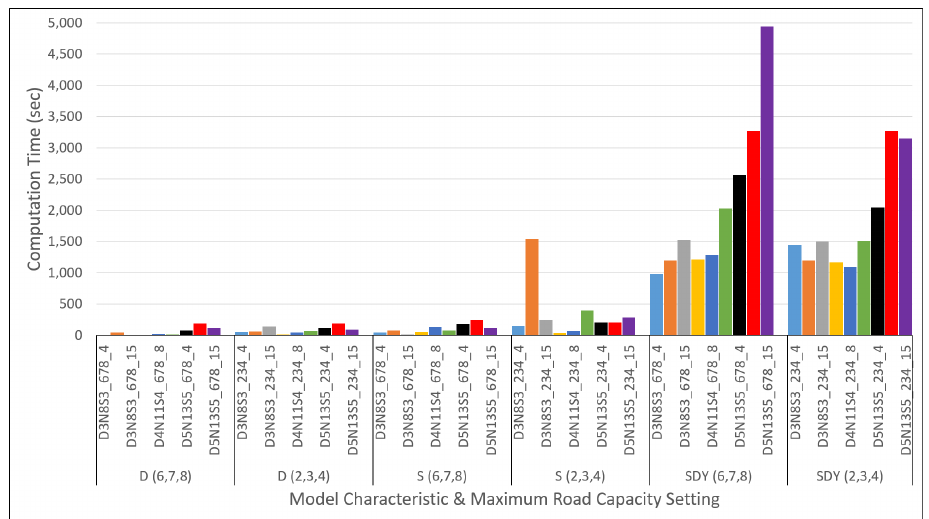
Figure A22. Computation Time in Online and Offline Computation for all Instances grouped by Model Characteristic and Maximum Road Capacity